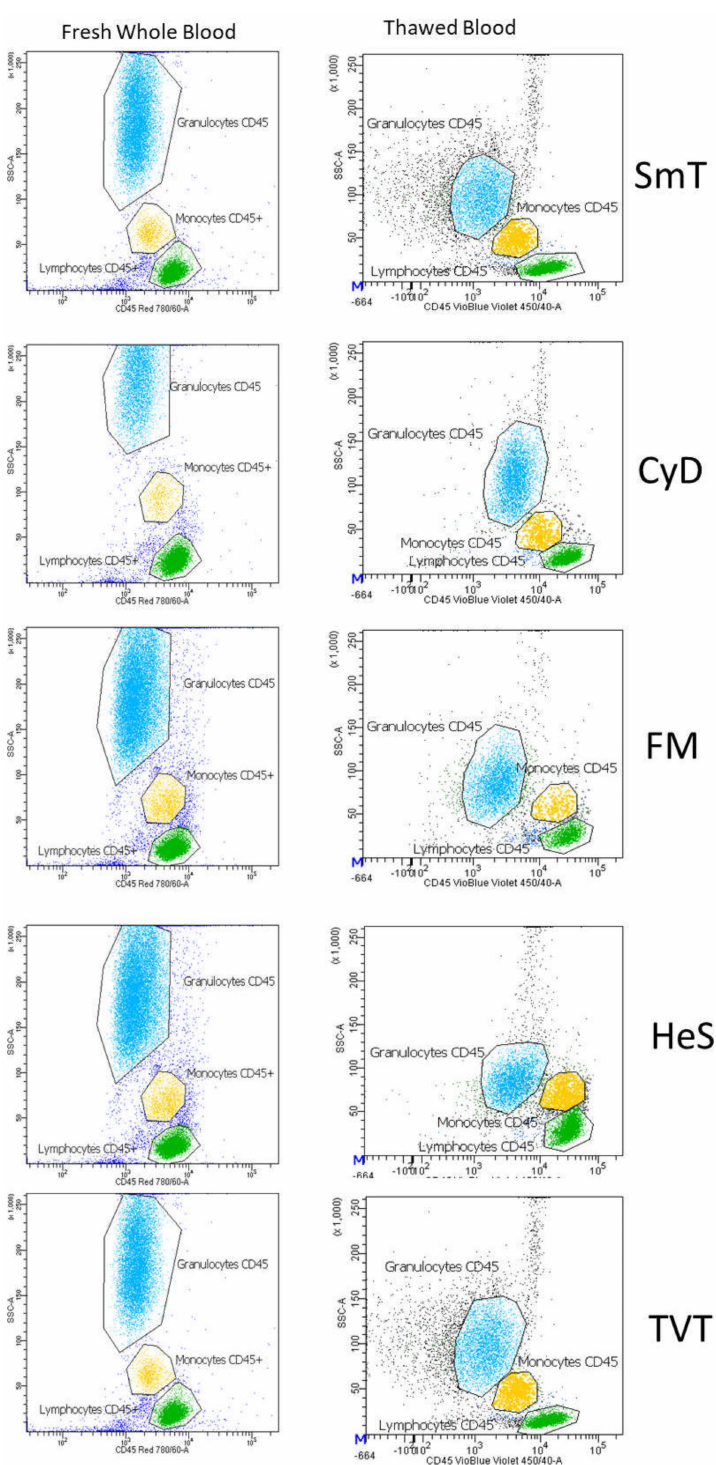
Figure 8. Representative leukocyte staining of fresh and thawed samples. Granulocytes CD45 (light blue), monocytes CD45 (yellow), and lymphocytes CD45 (green) are represented. Each freezing method is indicated on one line; the corresponding fresh whole blood is shown at the